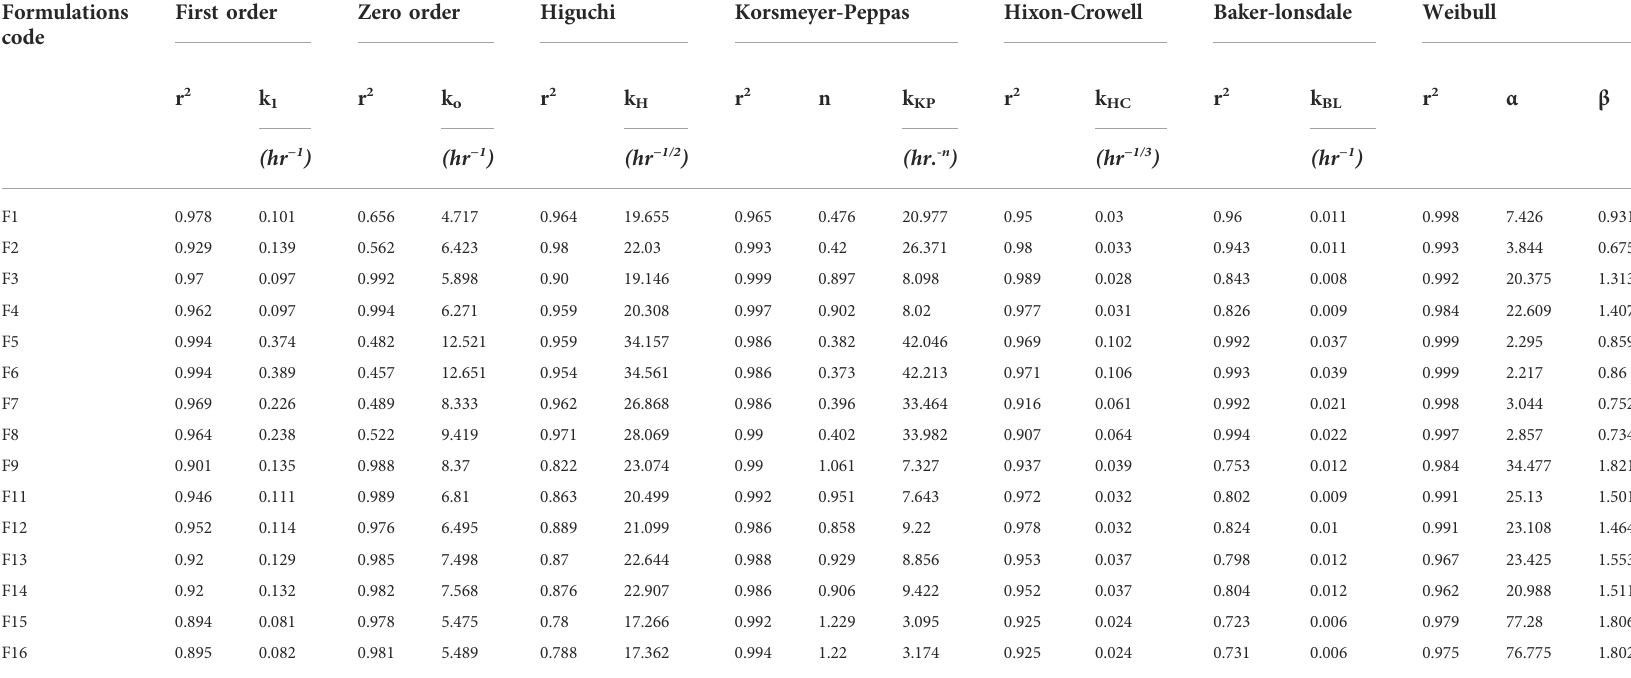
TABLE 6 The release rate and coef fi cient of correlation of tramadol osmotic formulations calculated by Model Dependent Kinetics. Formulations